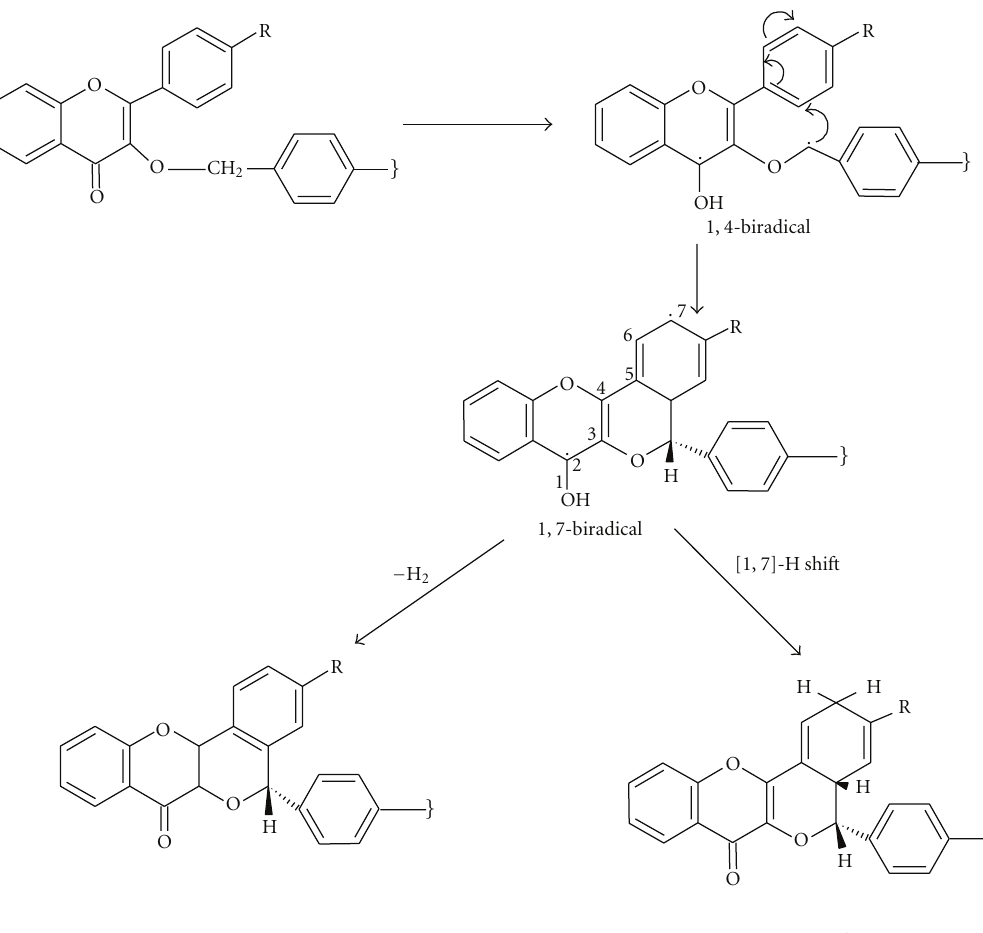
Scheme 3: Mechanism of the photocyclizations of bischromon-4-ones 2a-2c